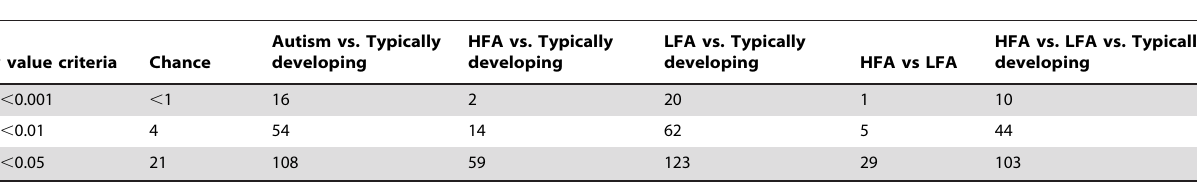
Table 4. Significant measures for study comparisons - intensity only.